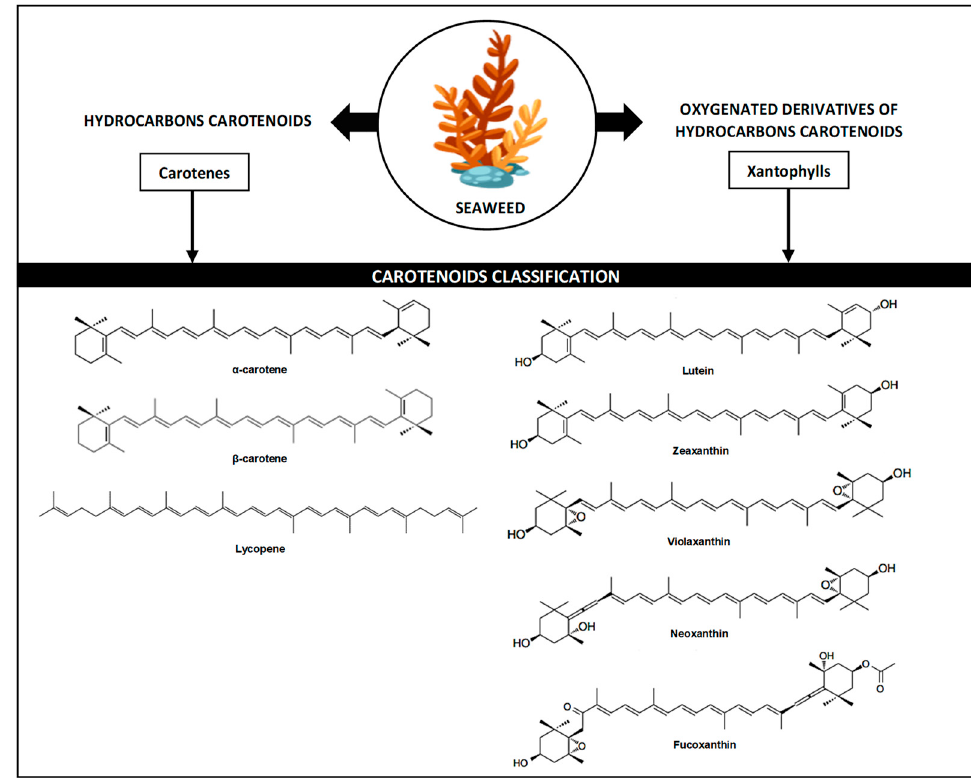
Figure 1. Summary of carotenoids classification in seaweed.